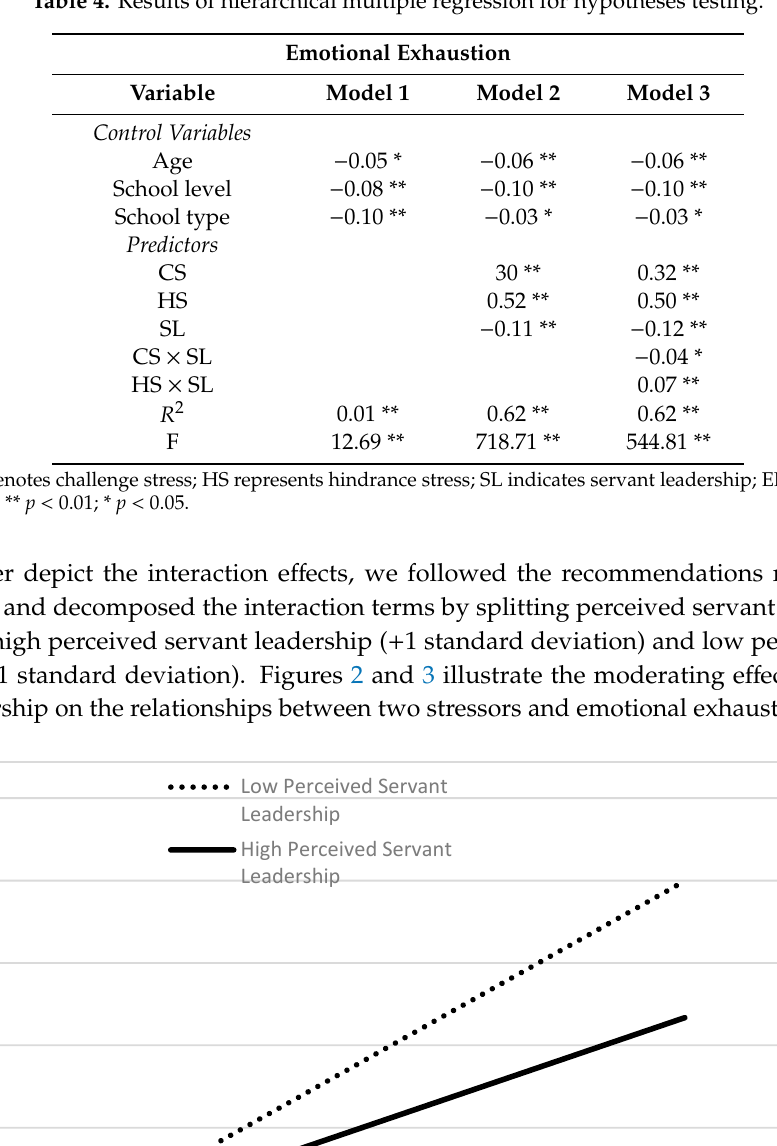
Table 4. Results of hierarchical multiple regression for hypotheses testing.